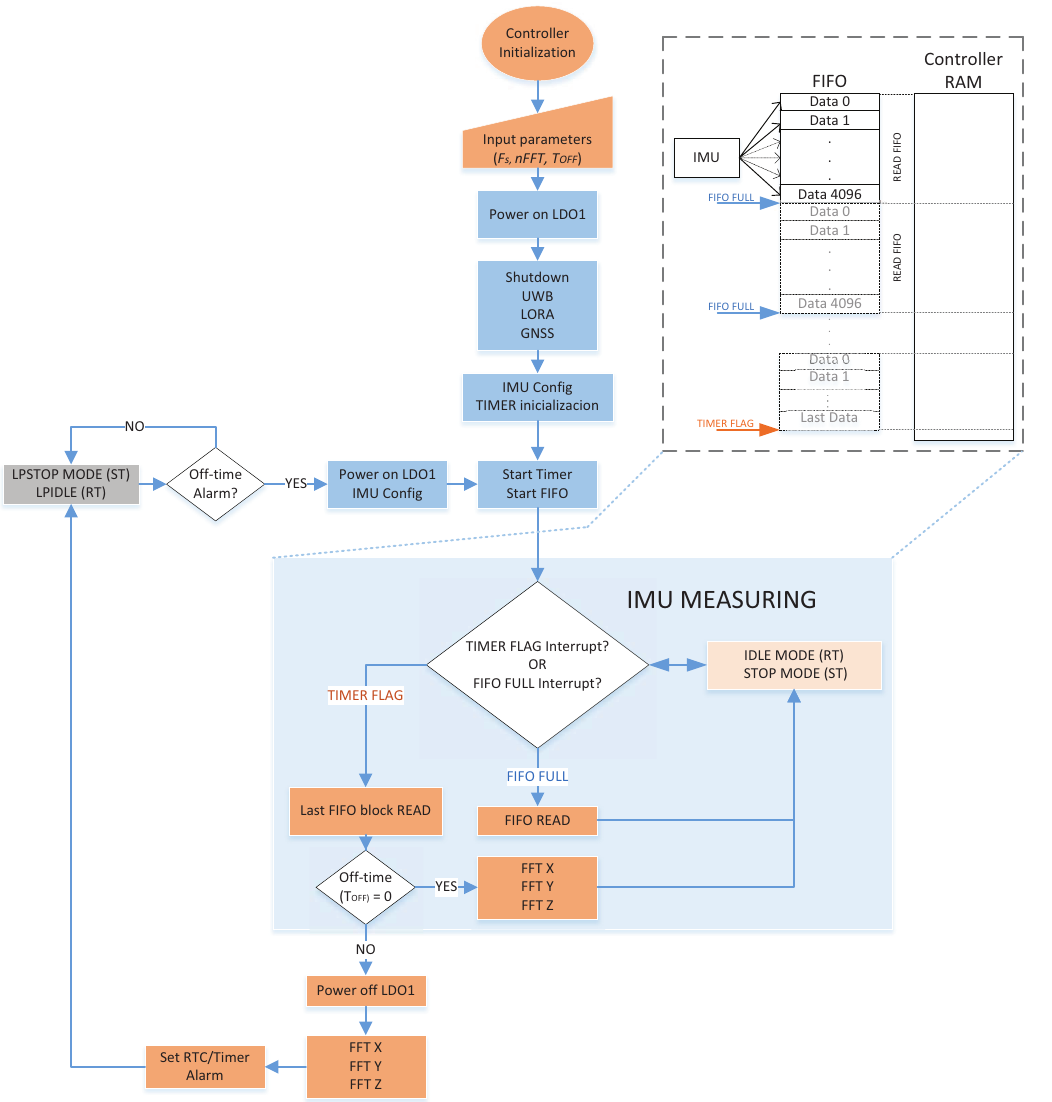
Figure 7. Flow chart of the proposed processing